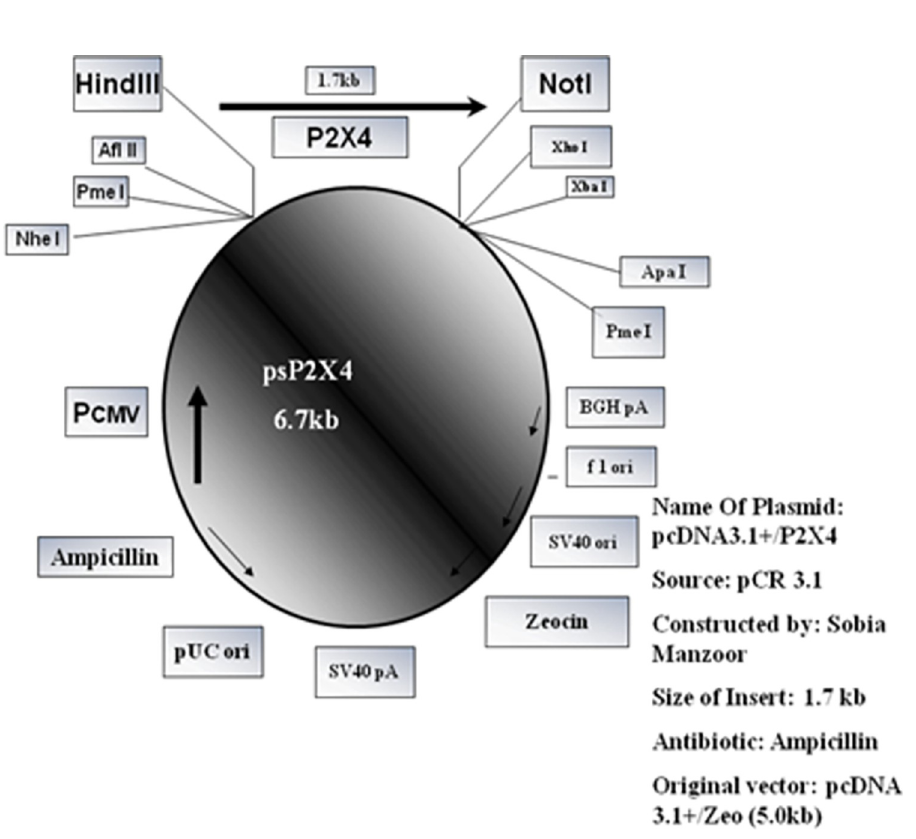
Fig 3. Map of construct pcDNA3.1+/P2X4.